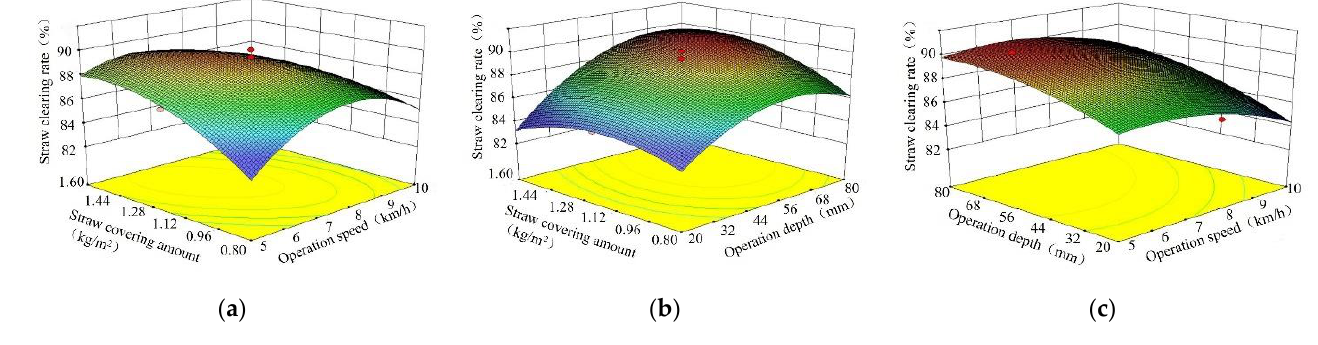
Figure 10. Influence law of various factors on straw clearing rate.